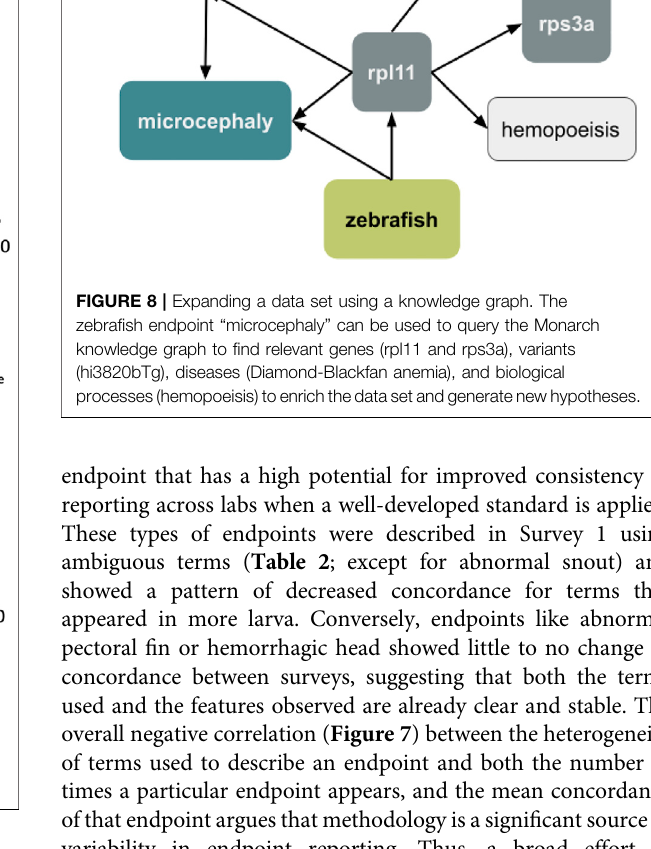
Frontiers in Toxicology |